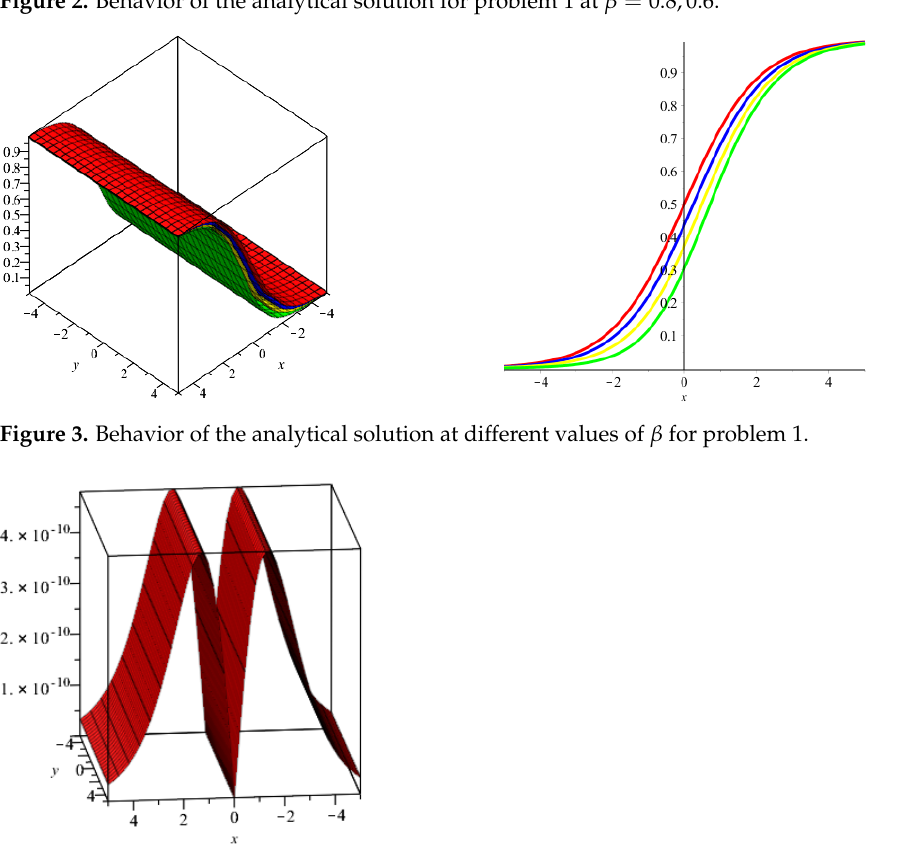
Figure 2. Behavior of the analytical solution for problem 1 at β = 0.8,0.6.